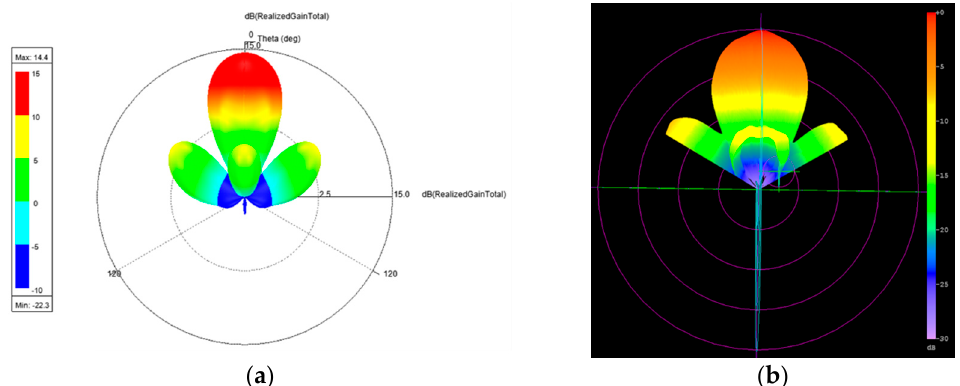
Figure 22. 3D radiation pattern of the array antenna at 28 GHz: ( a ) simulation result and ( b ) measurement result (normalized).